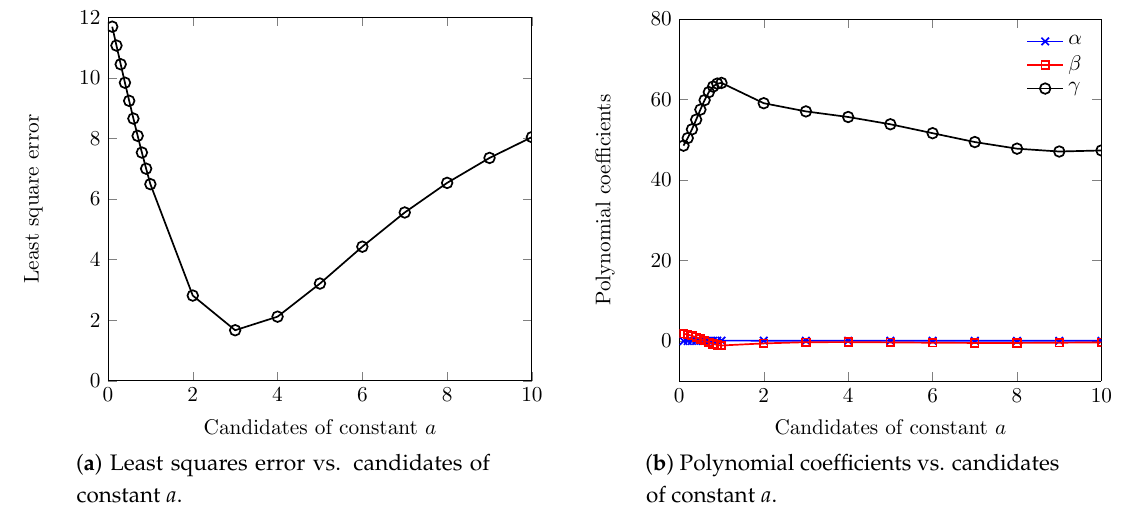
Figure 7. Lest squares error and polynomial coefficients at various candidates of constant a